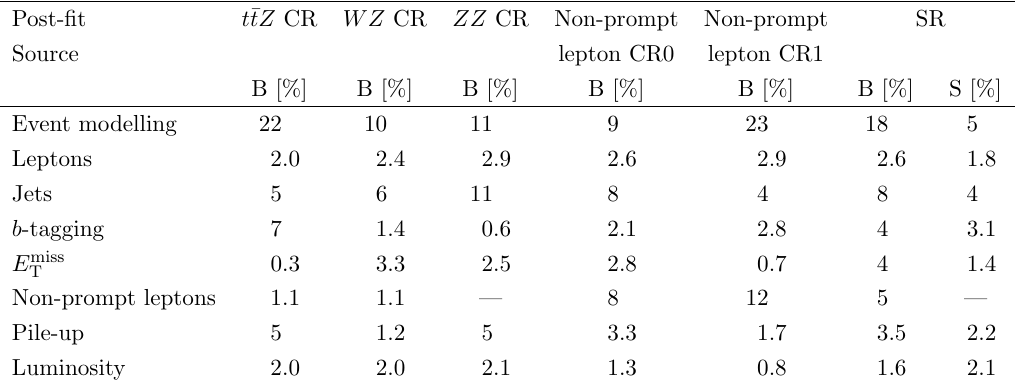
Table 7 . Summary of the relative impact of each type of uncertainty on the total background (B) yield in the background control regions and on the background and signal (S) yields in the signal region after the combined (cid:12)t under the background-only